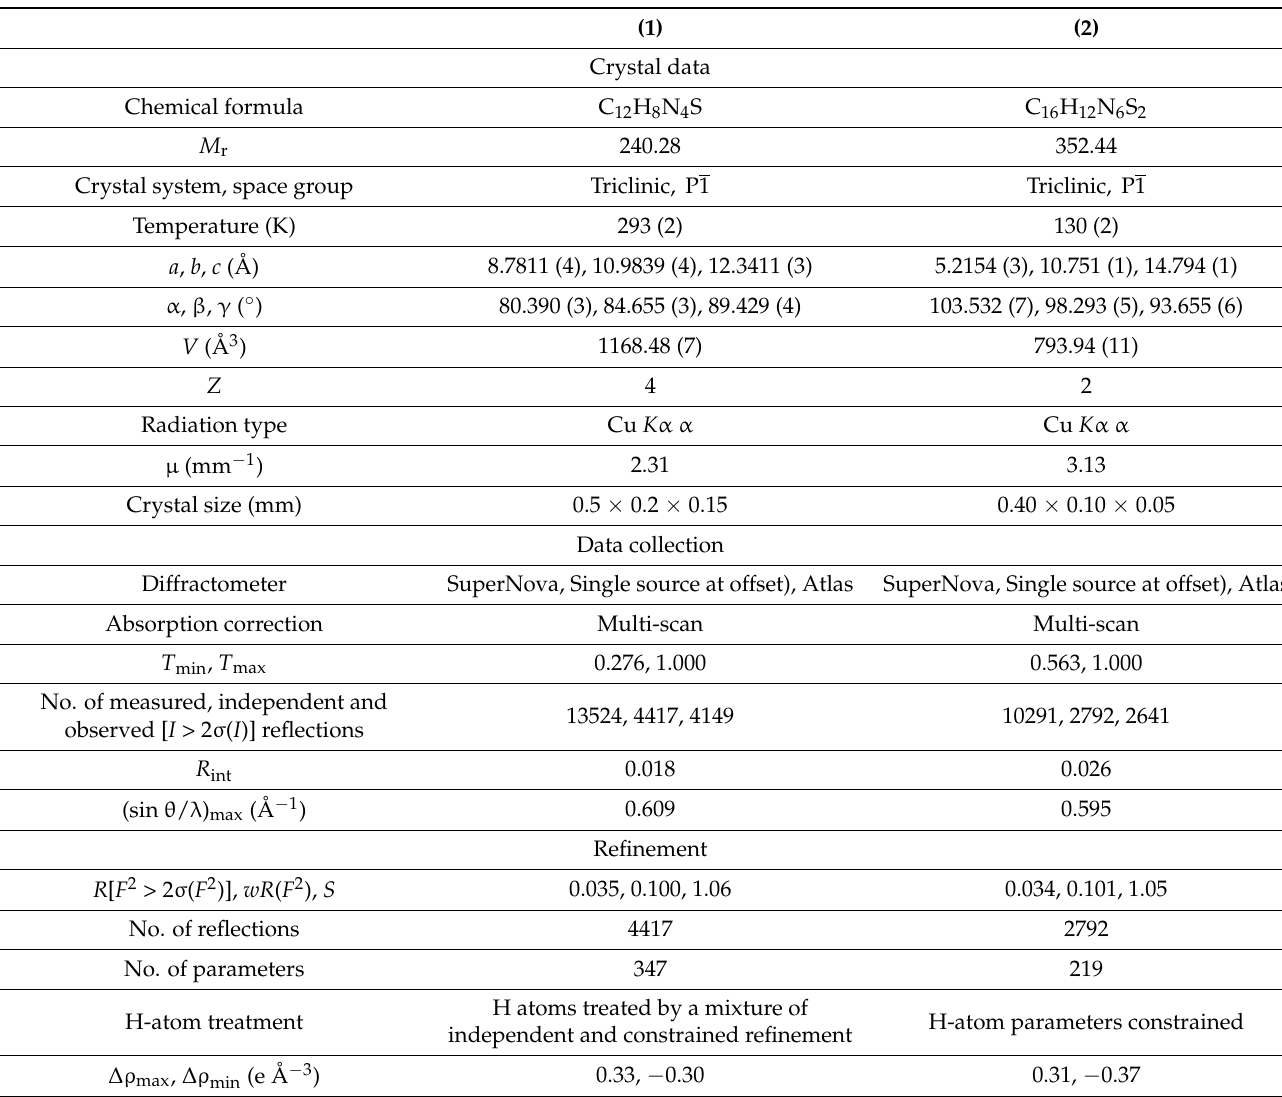
Table 4. Experimental details for 1 and